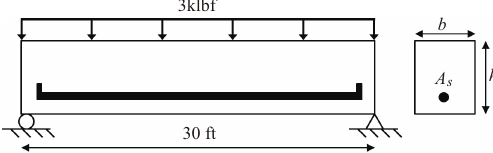
Figure 4. Configurationof a reinforced concrete